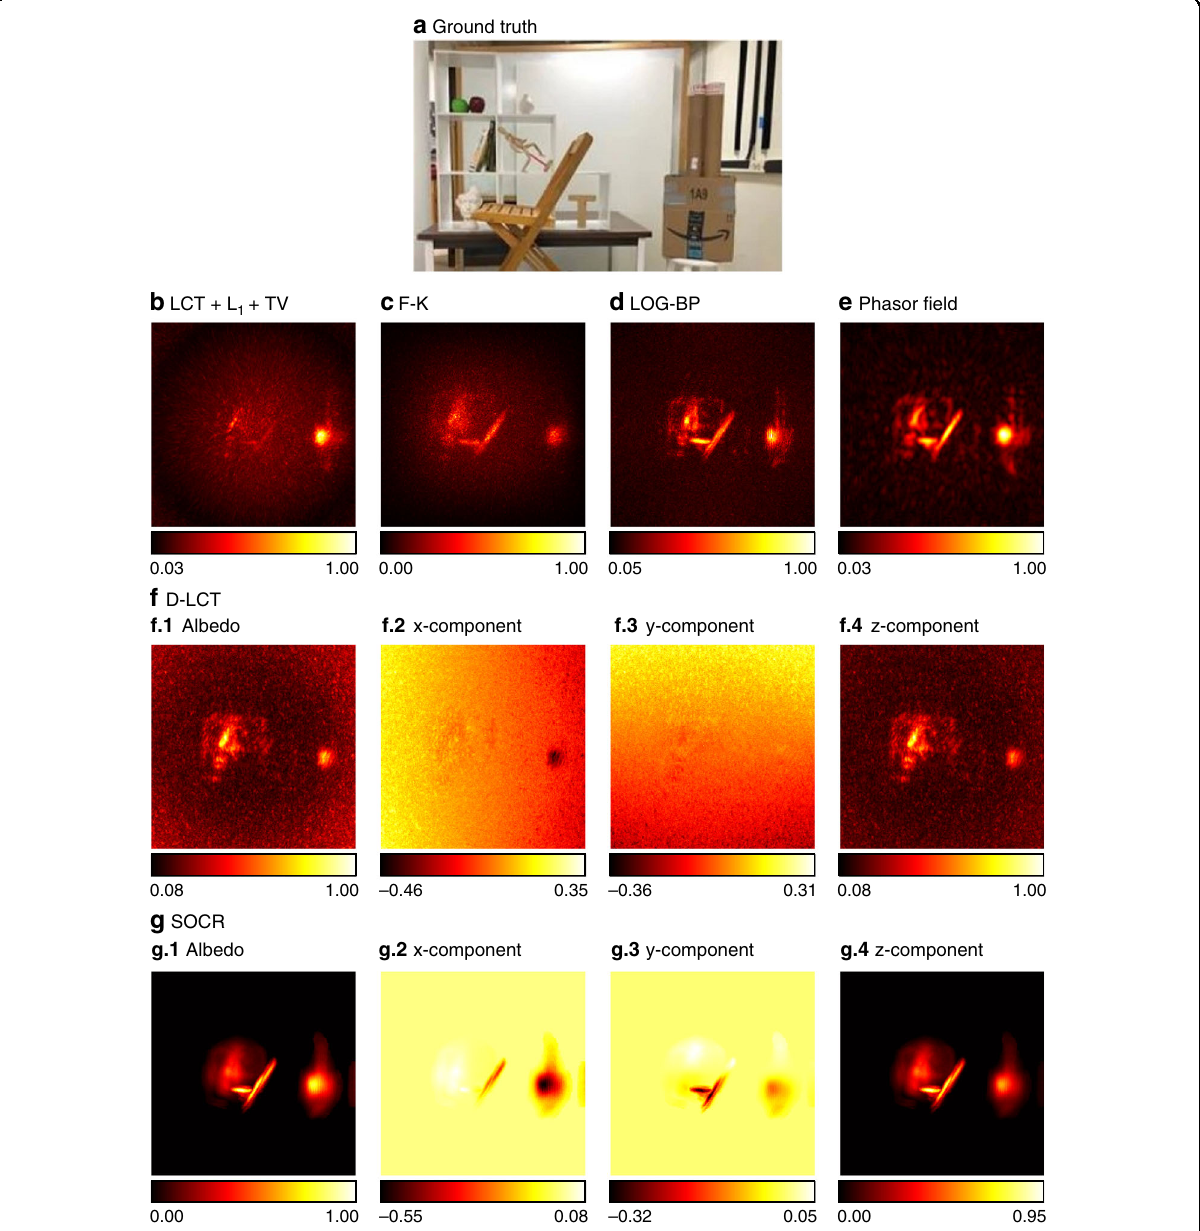
Fig. 14 Reconstruction results of the of fi ce scene (non-confocal, 23 s). The ground truth is shown in a . Reconstructions are shown in b – g . In this scene, the shelf is partially occluded by the chair, which makes it hard to reconstruct fi ne details. Reconstructed targets obtained with the LCT + L 1 + TV, F-K and D-LCT methods are noisy. The LOG-BP and phasor fi eld reconstructions contain artifacts. The proposed method provides a smooth reconstruction of the